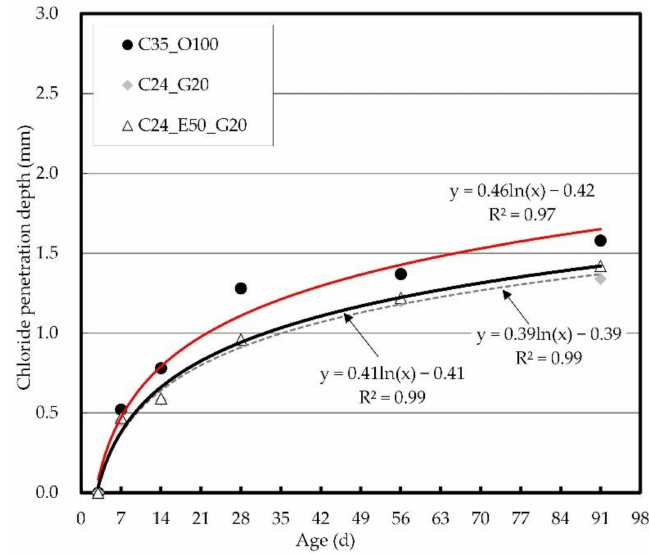
Figure 8. Chloride penetration depth by age.